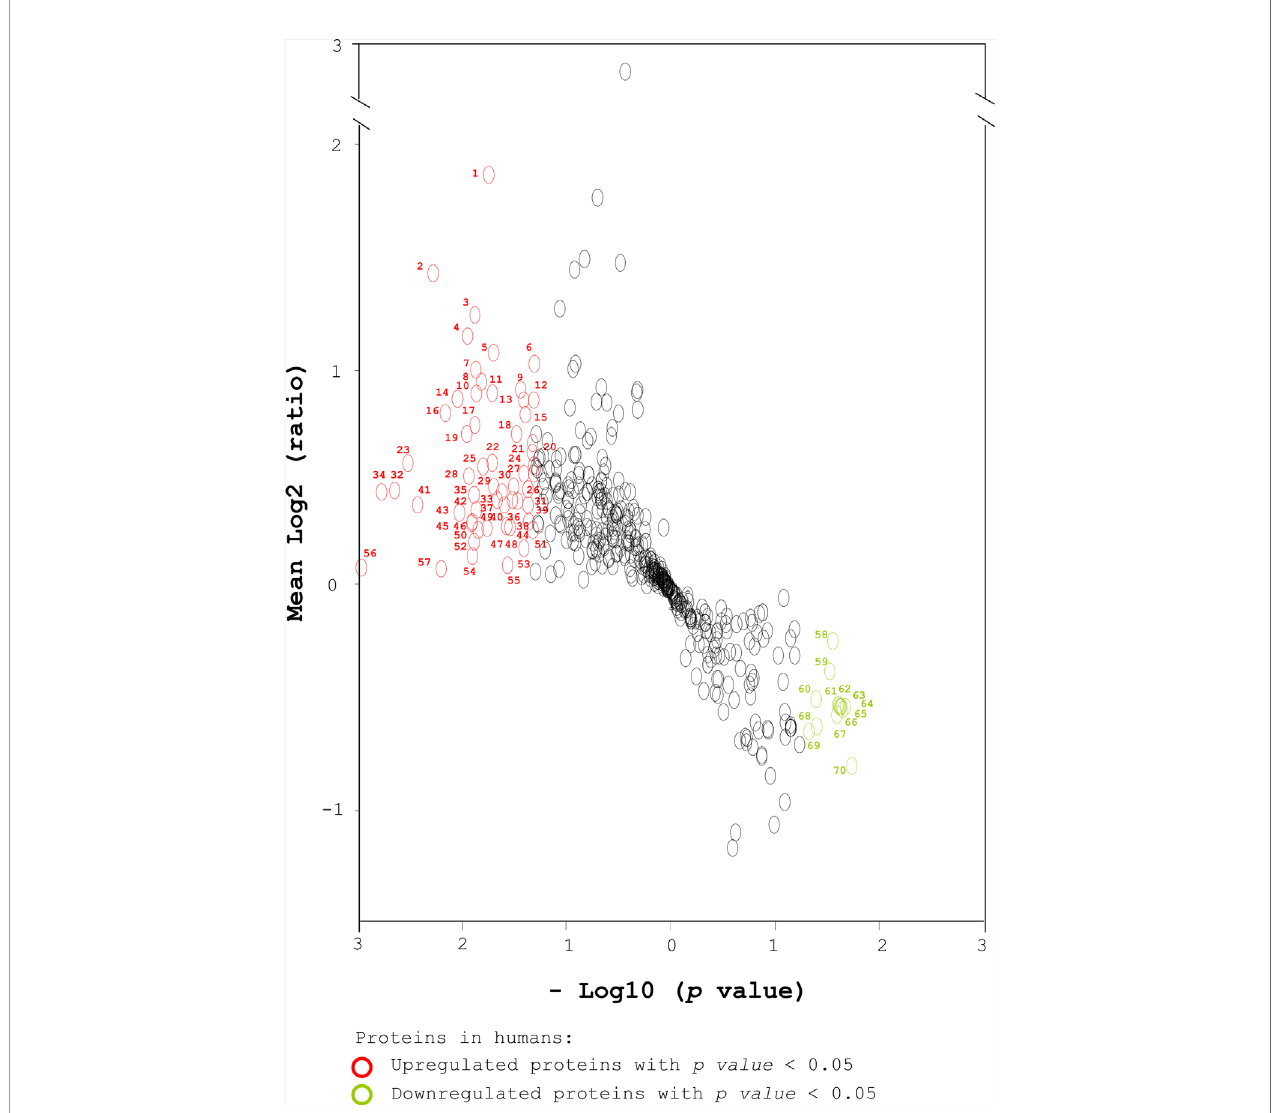
FIGURE 2 | Transformed volcano plot analysis of the selected proteins from human sera. Total proteins from human sera were labeled with iTRAQ tags, followed by MS analysis and Mascot identi fi cation. A total of 1074 human serum proteins were identi fi ed (ProteomeXchange, PXD017472). Five hundred proteins were selected based on a peptide Mascot score > 12 and number of unique peptide matches ≥ 2 ( Figure 1 ). A transformed volcano plot was used to analyze log2 (ratio of the level of one serum protein in a pre-diabetic patient to its average level in healthy subjects). The serum proteins detected in humans are labeled with circles. Upregulated and downregulated proteins with p < 0.05 (*) are labeled in red and green respectively. The proteins with p < 0.01 (**) that were associated with diabetes, diabetic complications and obesity were selected for further analysis using IPA. Student ’ s t-test was used to compare the differences between healthy and pre-diabetic